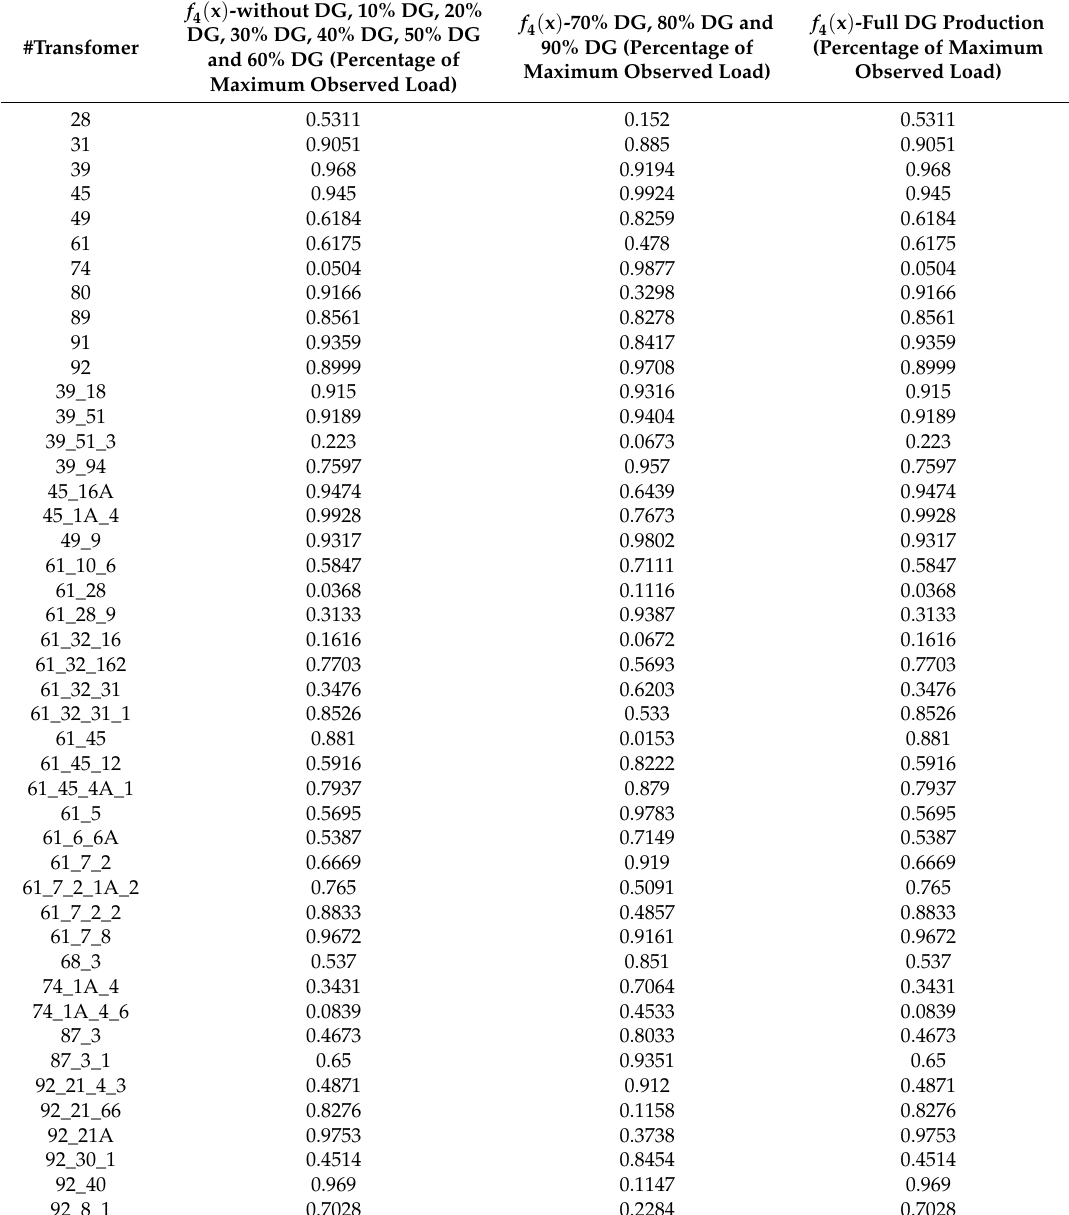
Table 6. Optimal loading per node according to f 4 ( x ) for increasing production up to the distributed generator’s installed